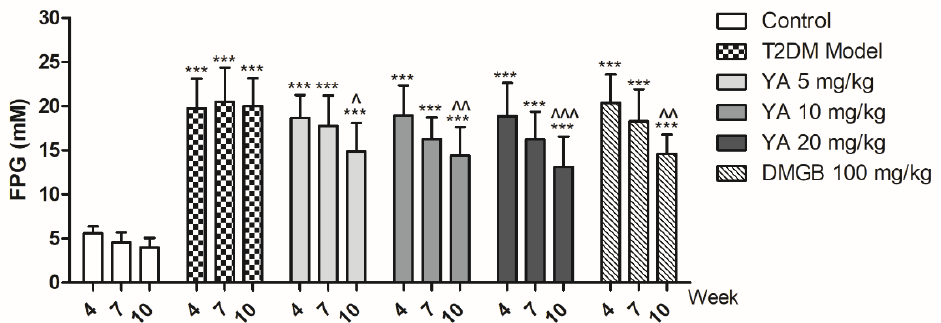
Figure 6. Fasting plasma glucose (FPG) of different groups during administration. Values are expressed as mean ± SD for each group. ( n = 8) (*** p < 0.001 vs. Control group, ˆ p < 0.05 vs. T2DM Model group at the 10th week, ˆˆ p < 0.01 vs. T2DM Model group at the 10th week, ˆˆˆ p < 0.001 vs. T2DM Model group at the 10th week).